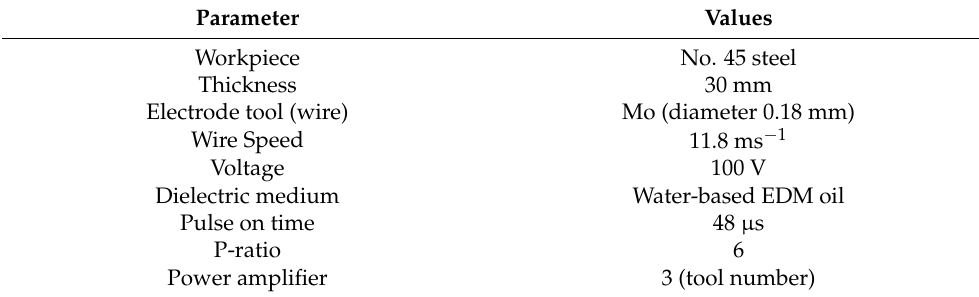
Table 1. Process